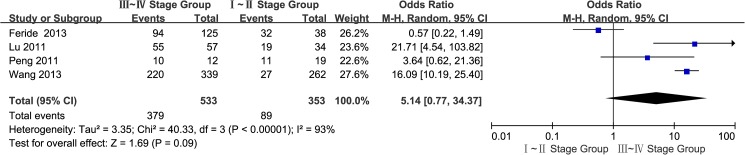
Meta-analysis of overexpression of EpCAM in Ⅲ~Ⅳ group andⅠ~Ⅱgroup.